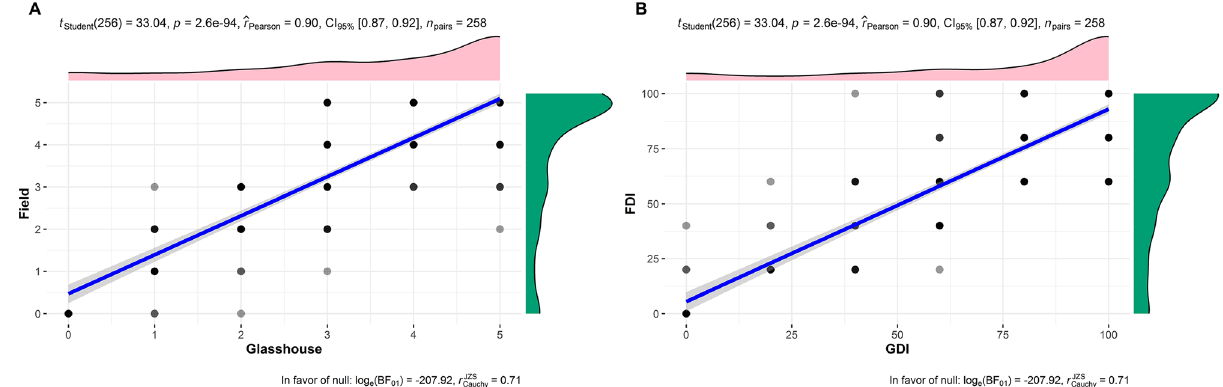
Figure 1. Pearson correlation analysis of the internal vascular discolouration score ( A ) and disease index ( B ) of the banana genotypes under glasshouse and field